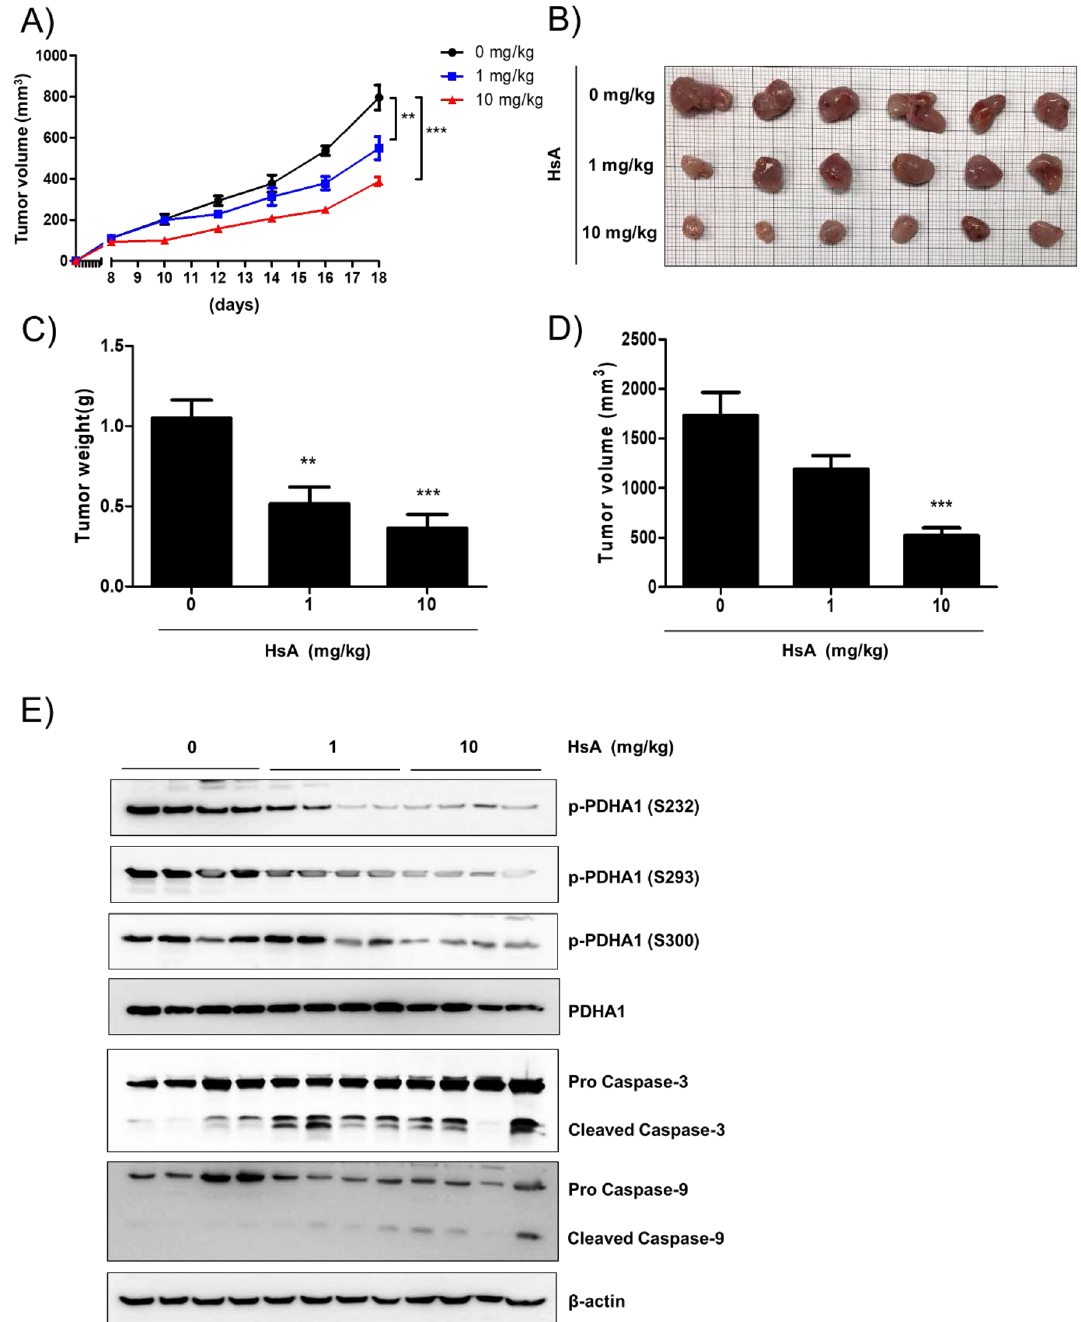
Figure 6. Anti-tumor activity of HsA in BALB/c mice bearing CT26 cells. CT26 cells were separated and suspended in PBS (5 × 10 6 cells/100 μL of PBS) and subcutaneously injected into the dorsal of 6-week-old BALB/c mice. The control group mice were injected 100 μL of corn oil and the HsA-treated groups were injected HsA (1 mg/kg, 10 mg/kg in 100 μL of corn oil/mice) once a dayfrom 8th day using abdominal injection for10 days. ( A ) The tumor volume of each mouse was measured every other day during the injection of HsA. ( B ) The tumor tissues were excised, and the images were taken. The weight ( C ) and volume ( D ) of the tumors in each group were measured. The results ( C , D ) are shown as mean ± SEM. *p < 0.05 and ***p < 0.001 compared with the control group. ( E ) The tumor tissues were lysed and the amounts of phosphorylated PDHA1(S232, S293,and S300), total PDHA1, caspase-3, and caspase-9 were measured by Western blot analysis. β-actin expression was used as a loading